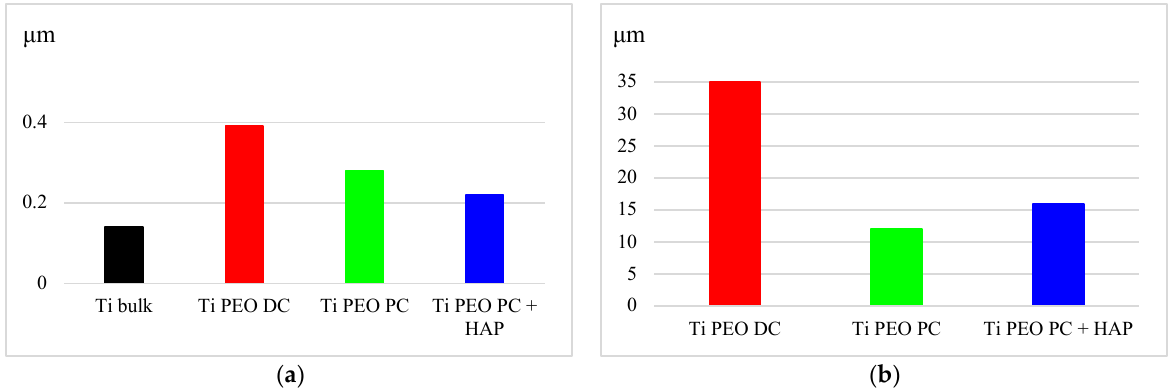
Figure 3. ( a ) Average surface roughness ( Ra ) of Ti substrate, Ti PEO DC; Ti PEO PC; Ti PEO PC + HAP; ( b ) Coating thickness of Ti PEO DC; Ti PEO PC; Ti PEO PC + HAP.